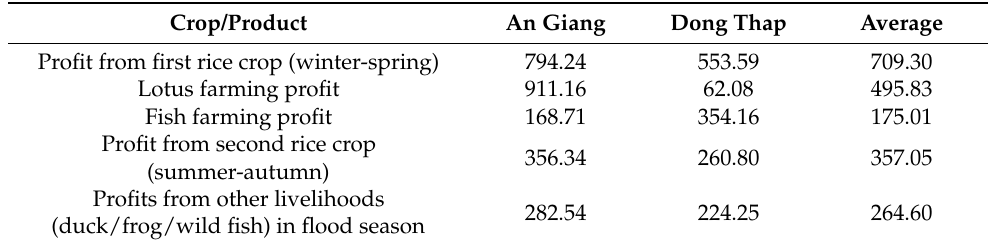
Table 2. Profit from Crops in Study Area, i.e., Rice, Lotus and Other Products, surveyed on December 2018